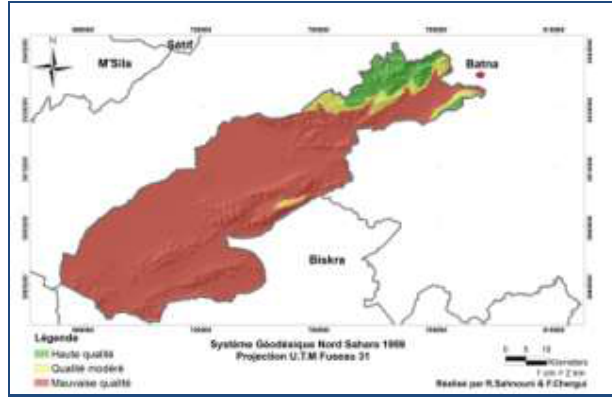
Figure 3. Climate quality map of southern massif Belezma Table 9. Distribution of soil quality areas The very favourable climate class occupy an area of 747,926 Km2 or 29.91% of the total area of 2,500.1 km ², with a quality index below 1.34. This class is located in higher altitudes with relatively heavy rainfall. The favourable class covers an area of 744.908 km ² or 29.79% and has an index between 1.34 and 1.81. It is the biggest of the three categories as the region of south Aurés is located in the arid zone where rainfall does not exceed 200 mm. The unfavourable class extends to the rest of the area, with a quality index above 1.81 and it is spread over the southern part of the case